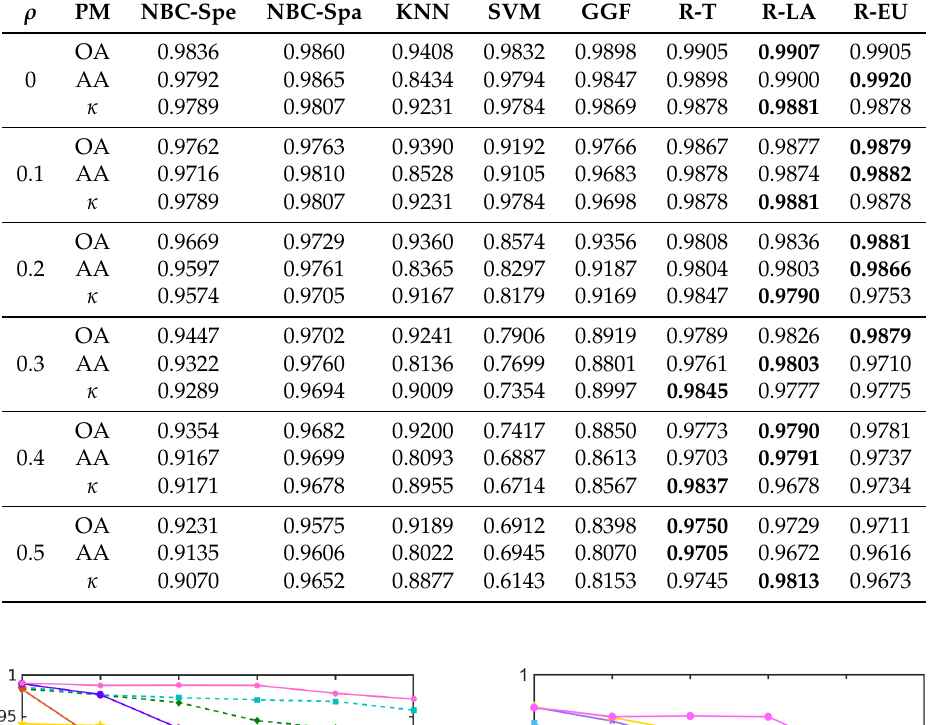
Table 8. Classification results for the Salinas Scene data set with different classifiers.